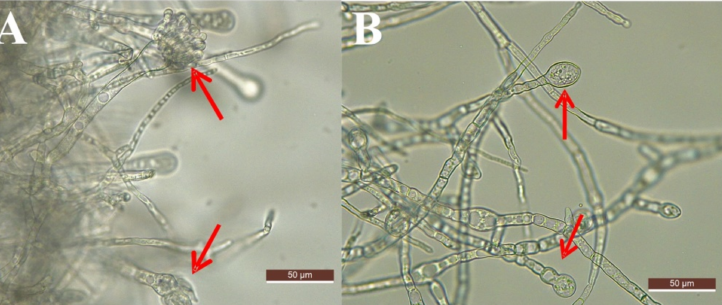
Figure 5. LPs released by Strain E2 exhibited an inhibitory effect on the growth of A. flavus ( × 400).